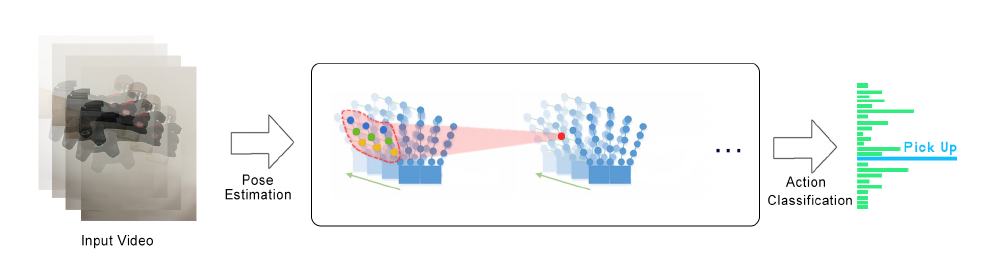
Figure 6. ST-GDN experiment flow